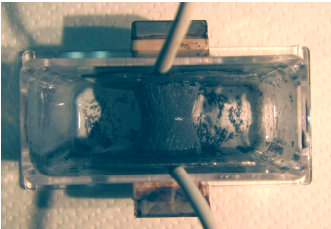
Figure 4. Photograph of MCF rubber liquid attracted to the electrodes before the application of electric field.